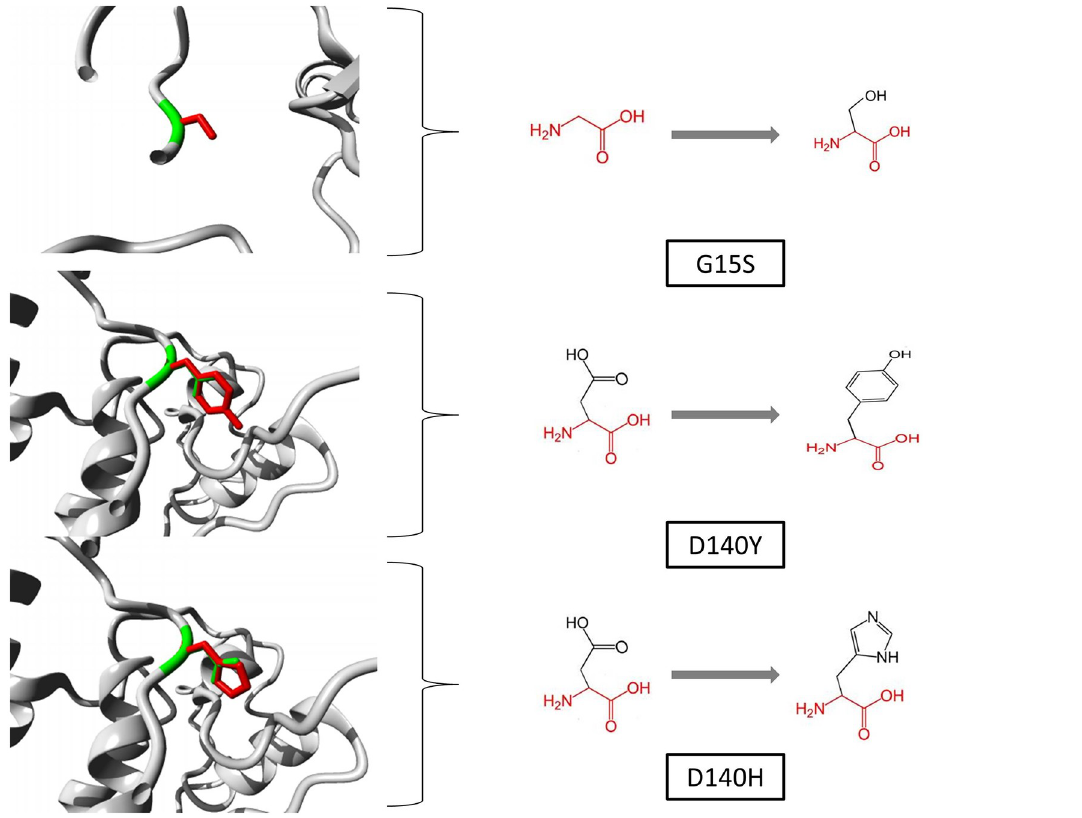
Fig 2. Project Hope server analysis of CDK4 native (green color) and mutant (red color) models to visualize the stereo chemical conformation of wild type and mutant residues at 15th and 140th positions.